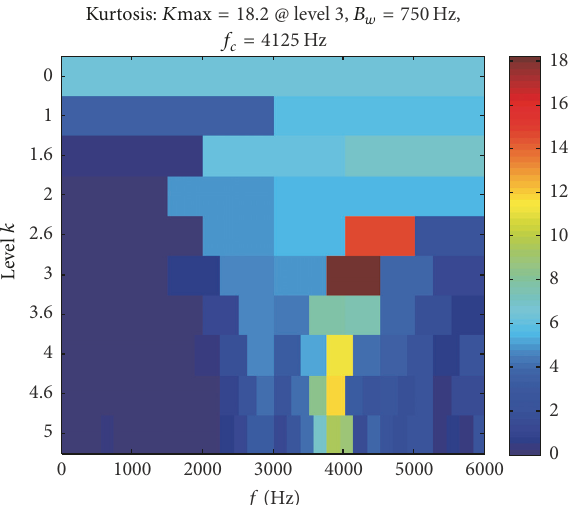
Figure 12: Processed results using fast kurtogram for detecting a rolling element fault. Central frequency 𝑓 𝑐 = 4125 Hz, bandwidth 𝐵 𝑤 = 750 Hz, and level 𝑘 = 3 .